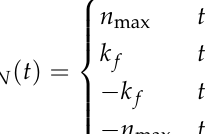
the delay t 0 . However, the t 0 change caused by β is very small, so the control performance is almost not influenced, which ensures the robustness of the controller. Figure 27f shows the result of the delay compensation control method when 5 MPa load is applied. According to Equations (32) and (33), with n max unchanged, the increase of the damping-like load will increase t 0 . As a result, the load increases the delay. In the positive half cycle of the sine command, the load direction is opposite to the command. In the negative half cycle of the sine command, the load direction is the same as the command. Therefore, the positive half cycle tracking performance is weakened, while the negative half cycle tracking performance is enhanced. However, compared with the result without the compensation control method (as shown in Figure 19, even without load), it can achieve a good control effect. However, to improve the control effect, the controller should be modified according to Equation (33) when the load changes